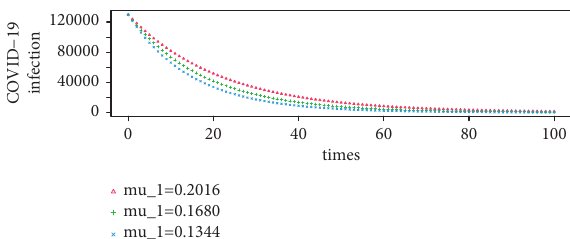
Figure 4: Simulation of COVID-19 infection at different rates of transmission. COVID-19 infection increases as the transmission rate of increases from 0.1344 to 0.2016. infection μ 1